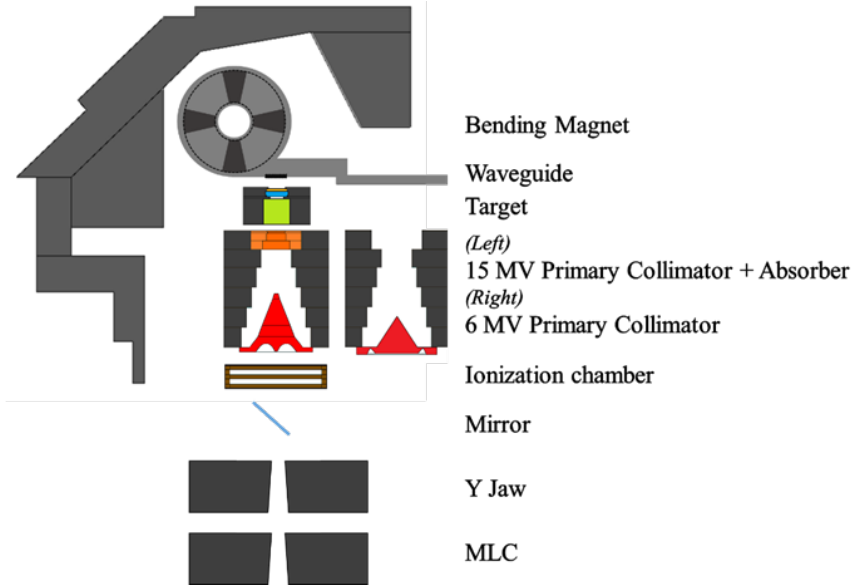
Figure 1. Components of the Siemens linac head.